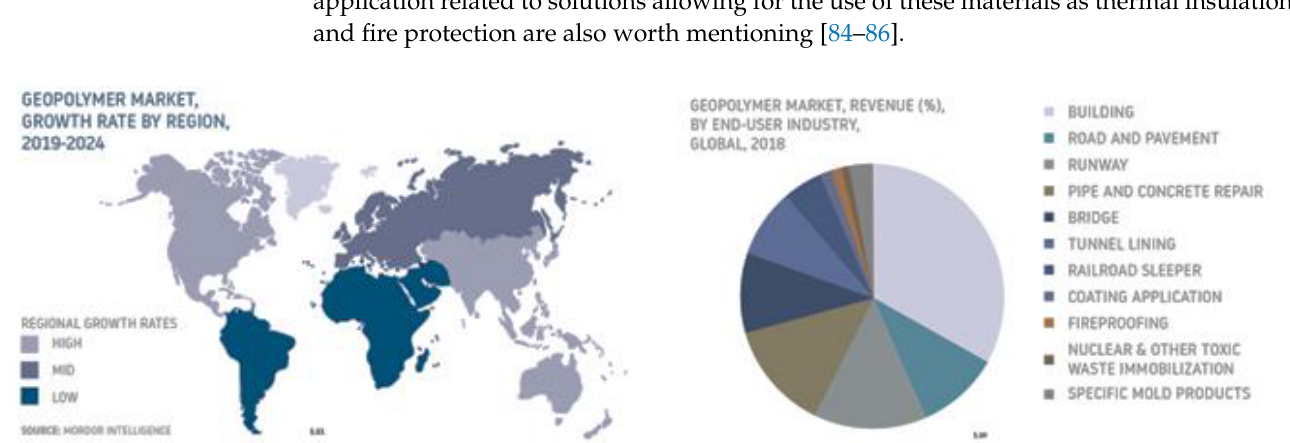
Figure 8. Geopolymer Products Market Forecast from 2019 to 2024 (source: Mordor Intelligence—online data).